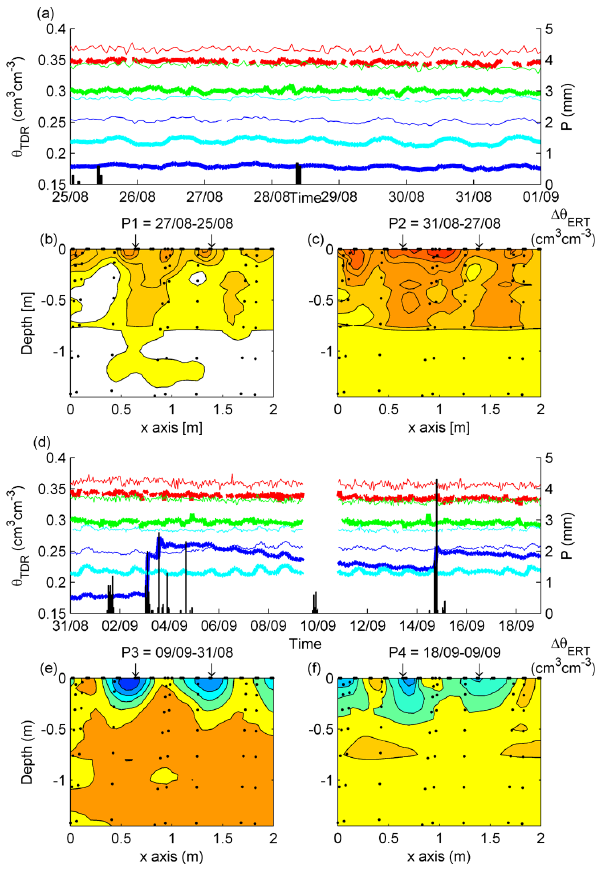
Fig. 15. TDR SWC content evolution during (a) P1 (25 to 27 Au- gust 2009) and P2 (27 to 31 August 2009) and (d) P3 (31 August to 9 September 2009) and P4 (9 to 18 September 2009). The bold lines correspond to the maize row TDR measurements and the thin lines to inter-row measurements. Blue is for 10cm depth, cyan for 30cm depth, green for 70cm depth and red for 125cm depth. The 2-D figures represent the ERT SWC differences for P1 (b) , P2 (c) , P3 (e) and P4 (f) . The colour scale corresponds to the SWC changes (cm 3 cm − 3 ). Negatives values mean a decrease of SWC and the positives values mean an increase of SWC. The arrows indicate the maize rows